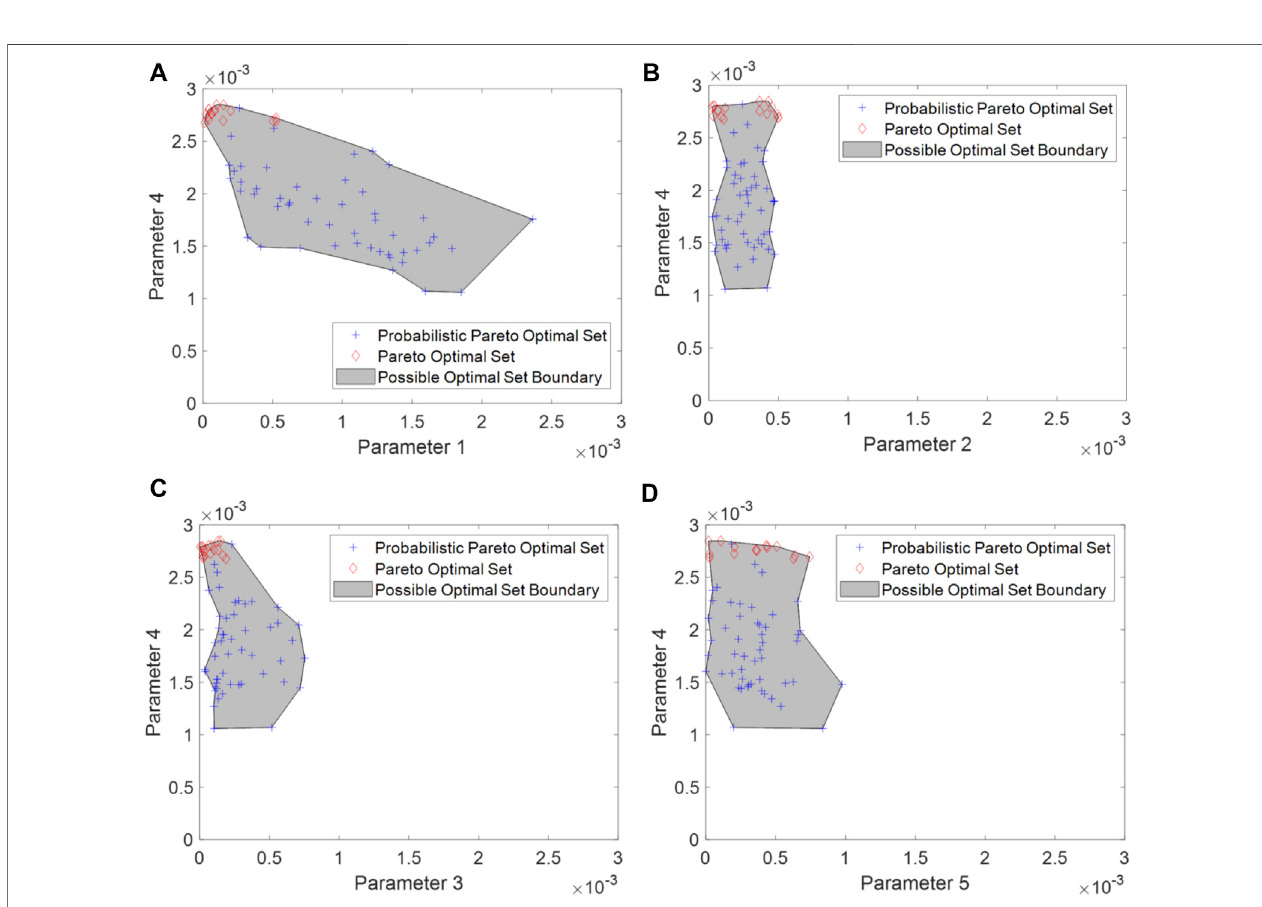
FIGURE 6 | Two-dimensional illustration of the probabilistic Pareto optimal set. (A) Parameter 1 versus Parameter 4; (B) Parameter 2 versus Parameter 4; (C) Parameter 3 versus Parameter 4; and (D) Parameter 5 versus Parameter 4 (note: the Pareto optimal set boundary is roughly estimated).